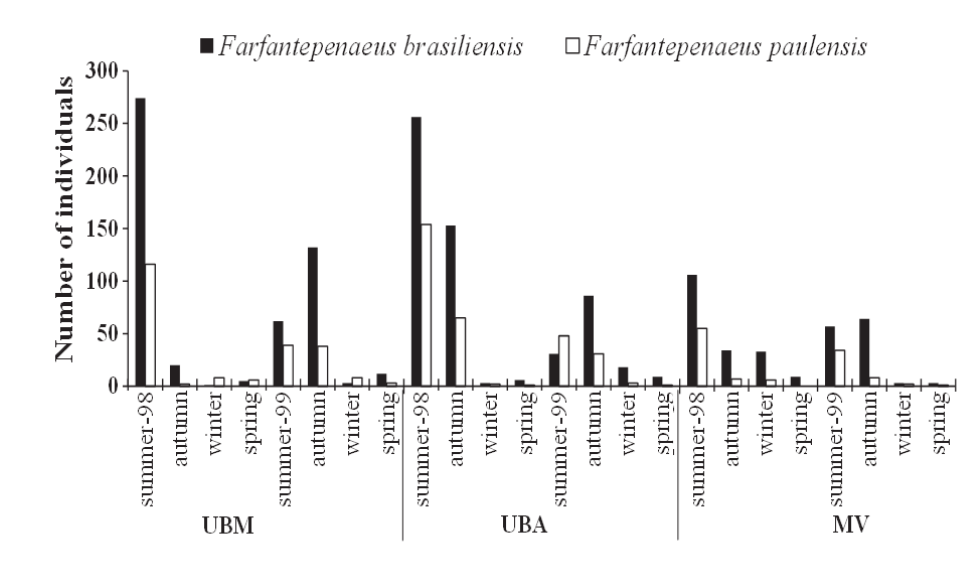
Figure 5. Number of individuals of Farfantepenaeus brasiliensis and F. paulensis captured seasonally from January 1998 to December 1999 in the bays of Ubatumirim (UBM), Ubatuba (UBA) and Mar Virado (MV).